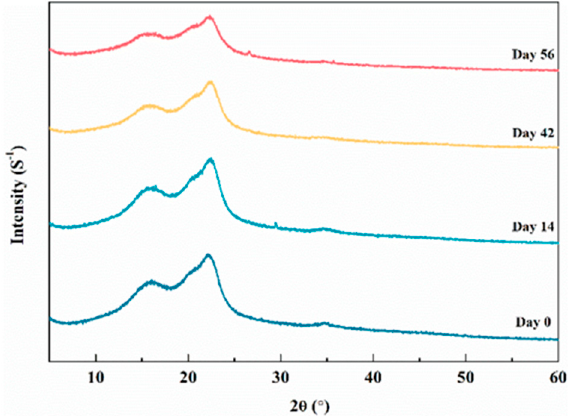
Figure 7. Relative crystallinity of environment-friendly bamboo fiber lunch box in different degradation stages.